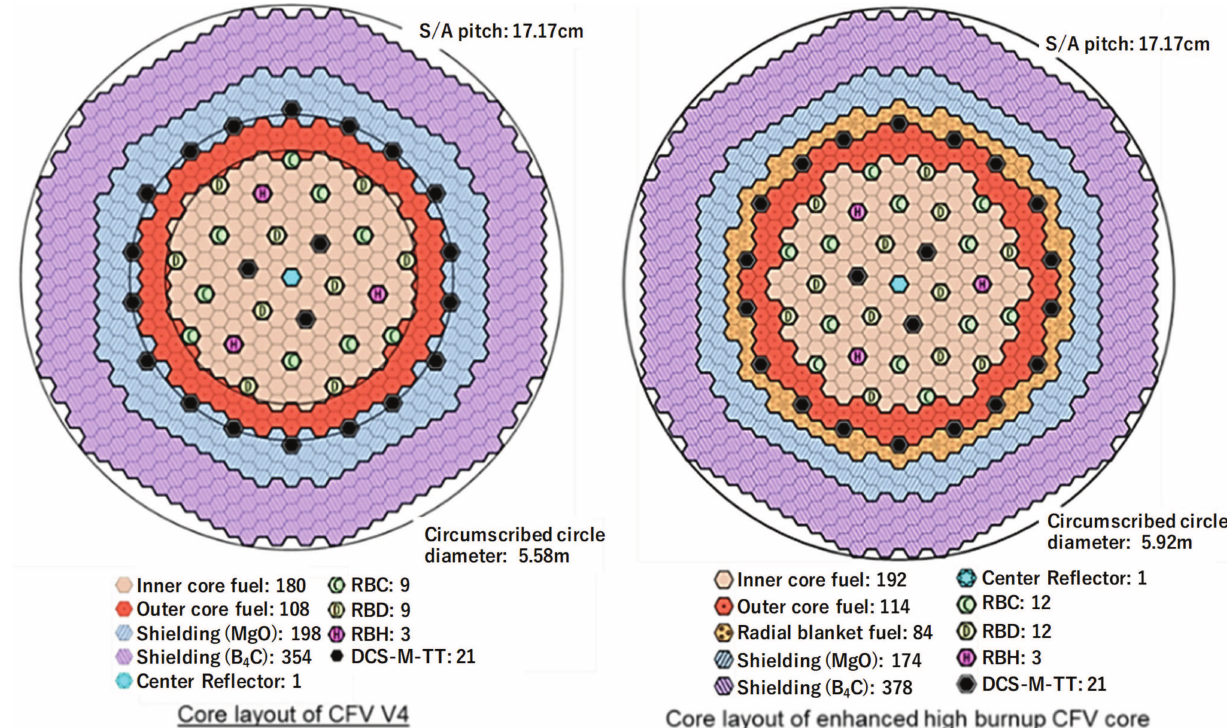
Fig. 1. Core configuration of CFV V4 core and enhanced high burnup CFV core.